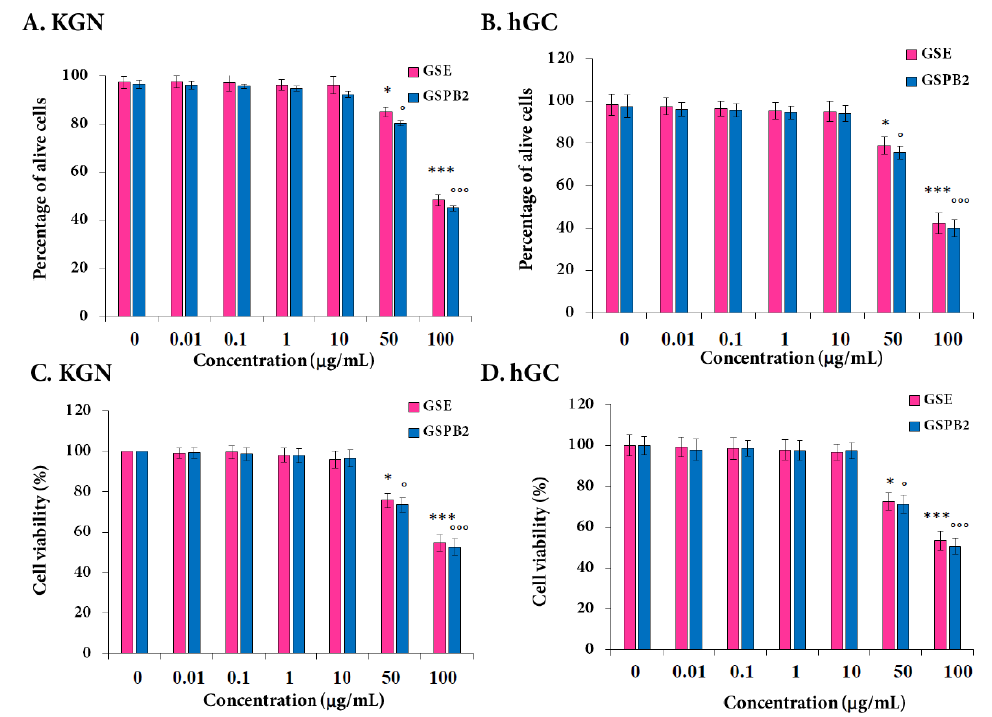
Figure 3. E ff ect of the GSE and GSPB2 treatments on the number of alive cells ( A , B ) and cell viability ( C , D ) in human granulosa cells. KGN ( A , C ) and hGC ( B , D ) cells were plated and incubated in various concentrations of GSE and GSPB2 (0, 0.01, 0.1, 1, 10, 50, and 100 µ g / mL for 24 h in appropriate medium with serum. Then, cell viability was measured by trypan blue staining ( A , B ) and Cell Counting Kit-8 (CCK8 reagent, C , D ) as described in Materials and Methods. The results are means ± SEM of four independent cultures with each condition in quadruplet. For the hGC cells, an independent culture was from a pool of cells collected from three patients. * and *** represent a significant e ff ect of GSE as compared to the control at p ≤ 0.05 and p ≤ 0.001, respectively. ◦ and ◦◦◦ represent a significant e ff ect of GSPB2 as compared to the control at p ≤ 0.05 and p ≤ 0.001,